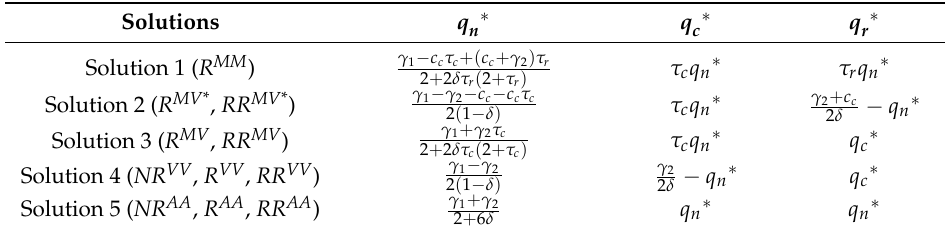
Table 4. Optimal decisions of the manufacturer in absence of cap-and-trade regulation.